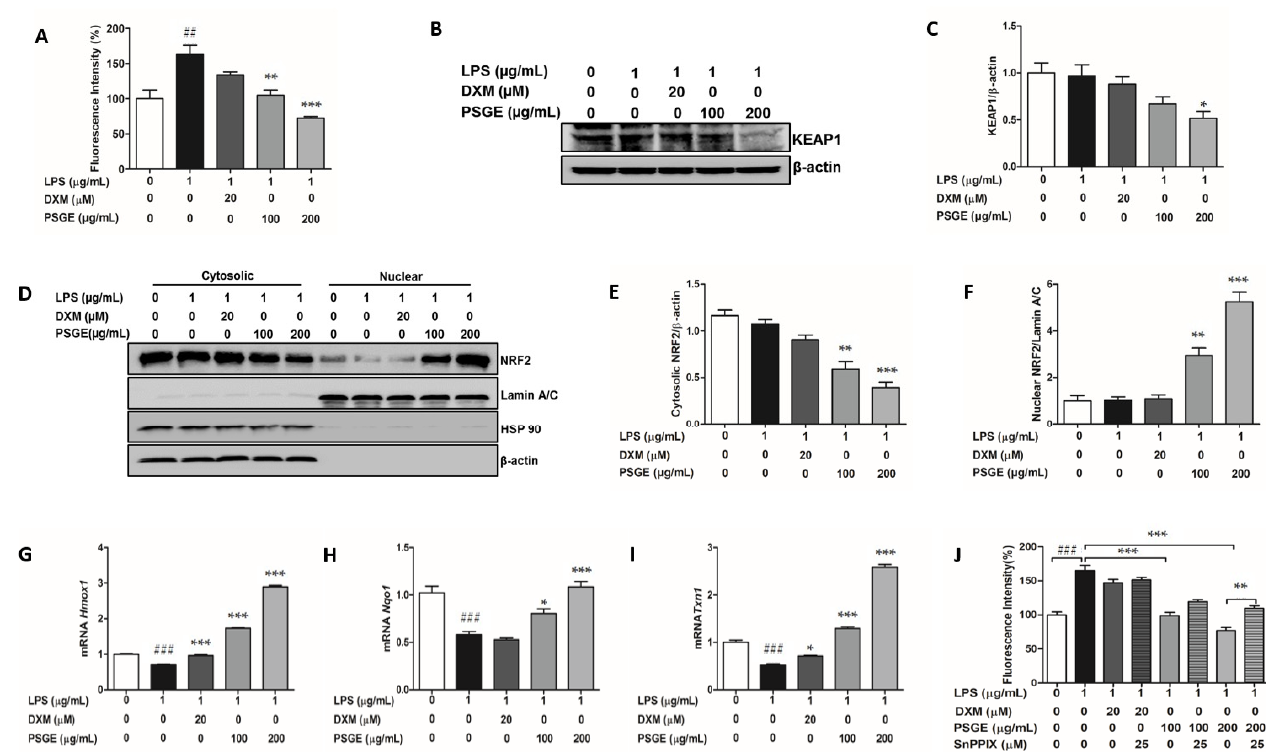
Figure 4. Effect of PSGE against LPS-induced intracellular ROS levels, KEAP1/NRF2 signaling and antioxidant gene expression in RAW 264.7 cells. ( A ) Intracellular ROS levels were assayed using oxidation of H 2 DCFDA fluorescence probe. RAW 264.7 cells were pre-treated with indicated concentration of PSGE or DXM for 2 h followed by LPS for 24 h.( B ) Protein expression and quantitative analysis of ( C ) KEAP1 relative to β -actin, ( D ) Western blot analysis of nuclear and cytosolic fractions using NRF2 antibody, quantitative analysis of ( E ) cytosolic NRF2 relative to β -actin, ( F ) nuclear NRF2 relative to Lamin A/C. RAW 264.7 cells were pre-treated with indicated concentration of the PSGE or DXM for 2 h followed by LPS for 30 min. The levels of ( G ) Hmox1 , ( H ) Nqo1 and ( I ) Txn1 mRNA expression were analyzed by RT-qPCR. RAW 264.7 cells were pre-treated with indicated concentration of the PSGE or DXM for 2 h followed by LPS for 2 h. ( J ) Changes in ROS levels by SnPPIX. RAW 264.7 cells were pre-treated with indicated concentration of SnPPIX (HO-1 inhibitor) for 1 h and then DXM or PSGE for 2 h followed by LPS for 24 h. Lamin A/C and HSP90 were used as cytosolic and nuclear markers. DXM as positive control. Data shown represent mean ± SEM ( n = 3). (## p < 0.01 and ### p < 0.001 vs. control; * p < 0.05, ** p < 0.01, and *** p < 0.001 vs.